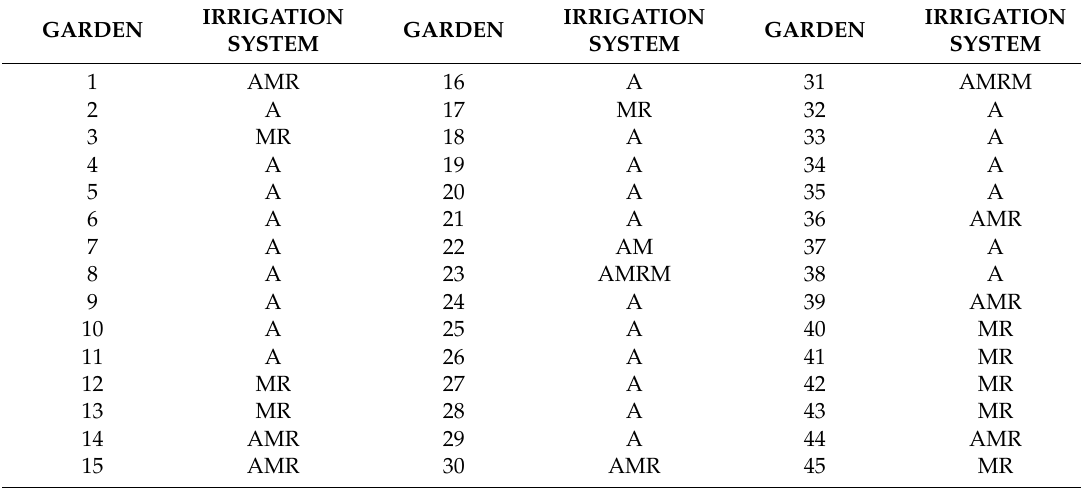
Table 1. Irrigation systems of the São Brás de Alportel urban gardens.